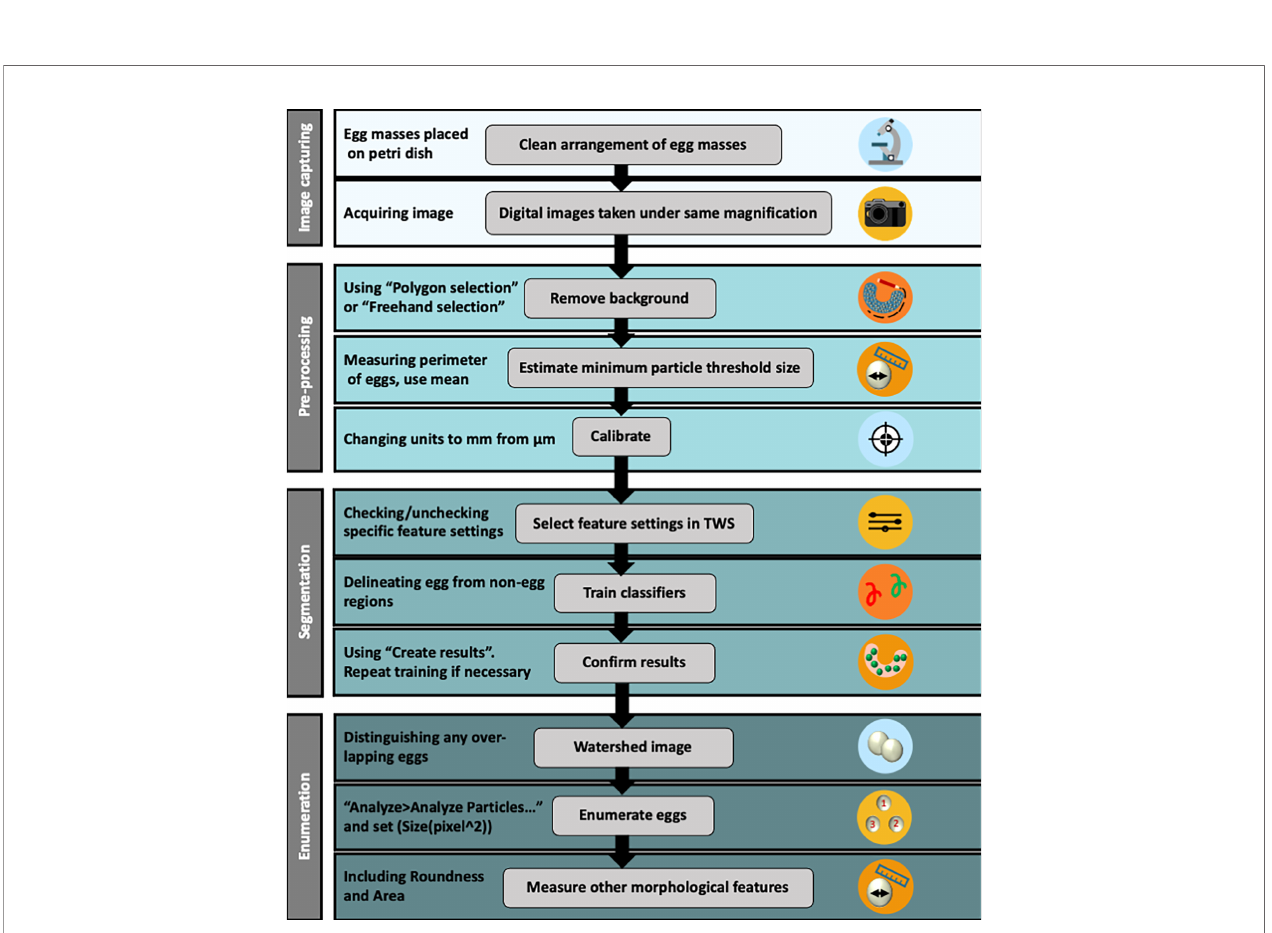
FIGURE 3 | Work fl ow procedures detailing steps beginning at image capturing, followed by data image pre-processing, segmentation and egg enumeration. See Supplementary Figure 1 for a more detailed version of the work fl ow